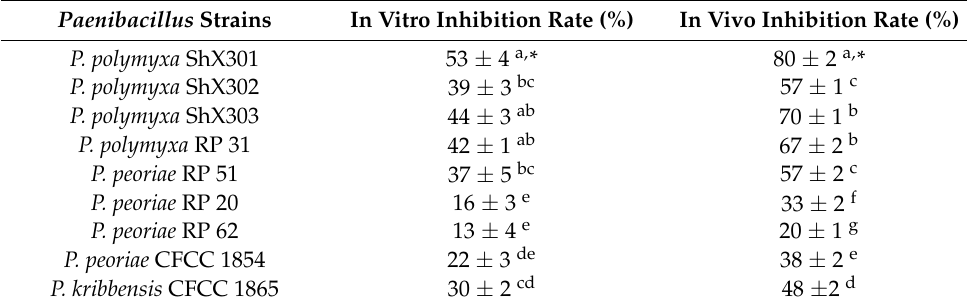
Table 2. Inhibition of Dickeya dadantii by strains within Paenibacillus polymyxa complex based on in vitro overlay culture assay and in vivo tuber slice assay.